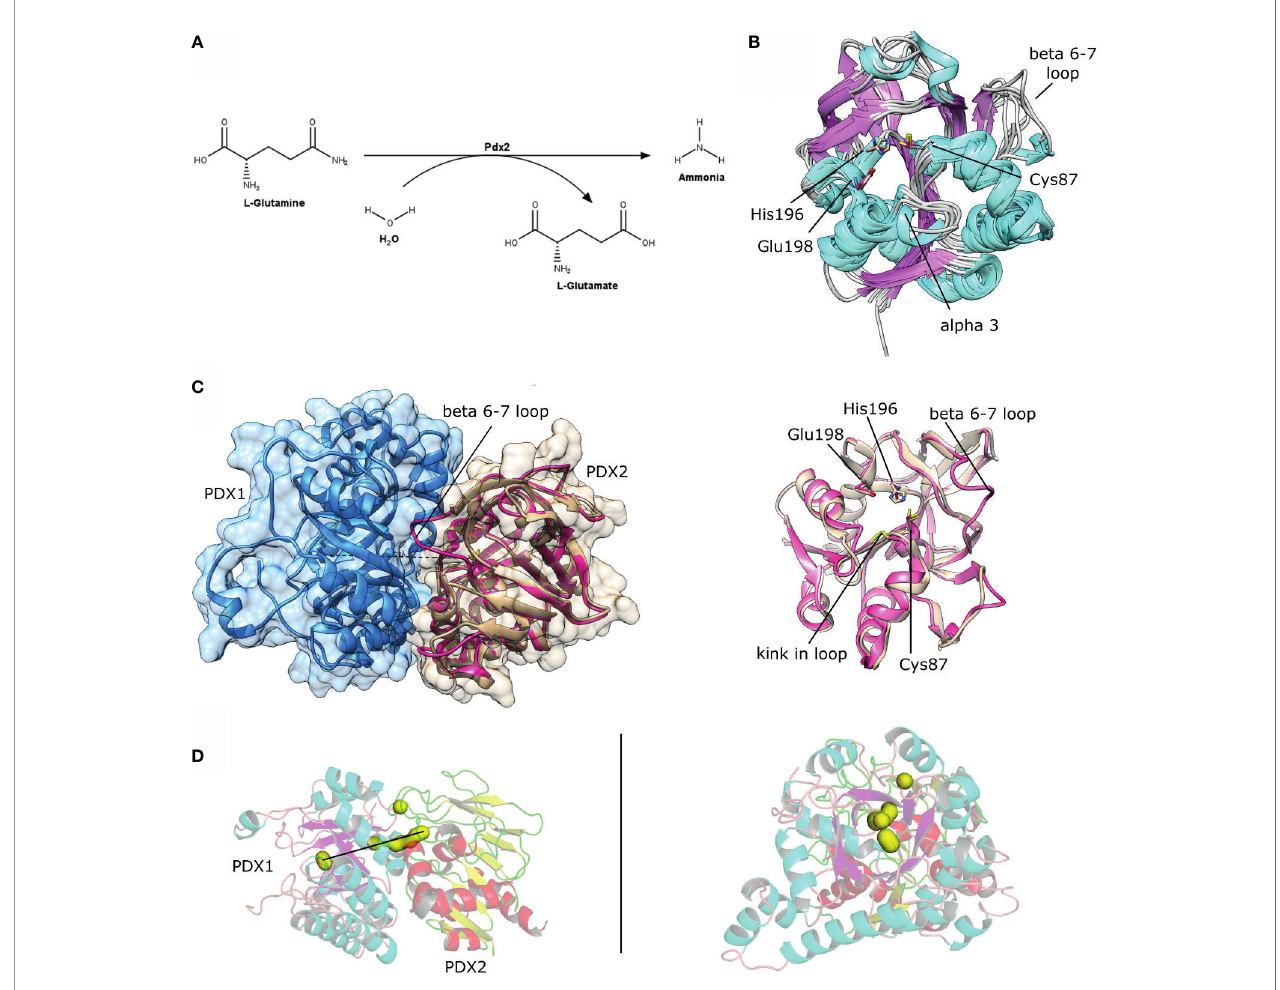
FIGURE 3 | (A) Scheme for the enzymatic reaction catalyzed by Pdx2. (B) Structural superposition of the crystal structures as available in the PDB for P. falciparum Pdx2 (PDB ID 2ABW), T. maritima (2ISS), G . kaustophilus (4WXY), B. stearothermophilus (1Q7R), B. subtilis (2NV0), M. jannaschii (2YWJ). (C) Left, structural view of the Pdx1 (shown in blue cartoon and surface) and Pdx2 (shown in brown and pink cartoon presentation). The loop linking b -strands b 6- b 7 is indicated in the fi gure and is part of the interacting interface. Right, superposition of PfPdx2 in the absence (brown) and presence (pink) of Pdx1. (D) Two orthogonal views of the Pdx1- Pdx2 interaction. Some clefts in the complex are shown in yellow surface representation, indicating a putative way for the ammonia tunnel. The fi gure was prepared with UCSF Chimera (Pettersen et al., 2004) and the program